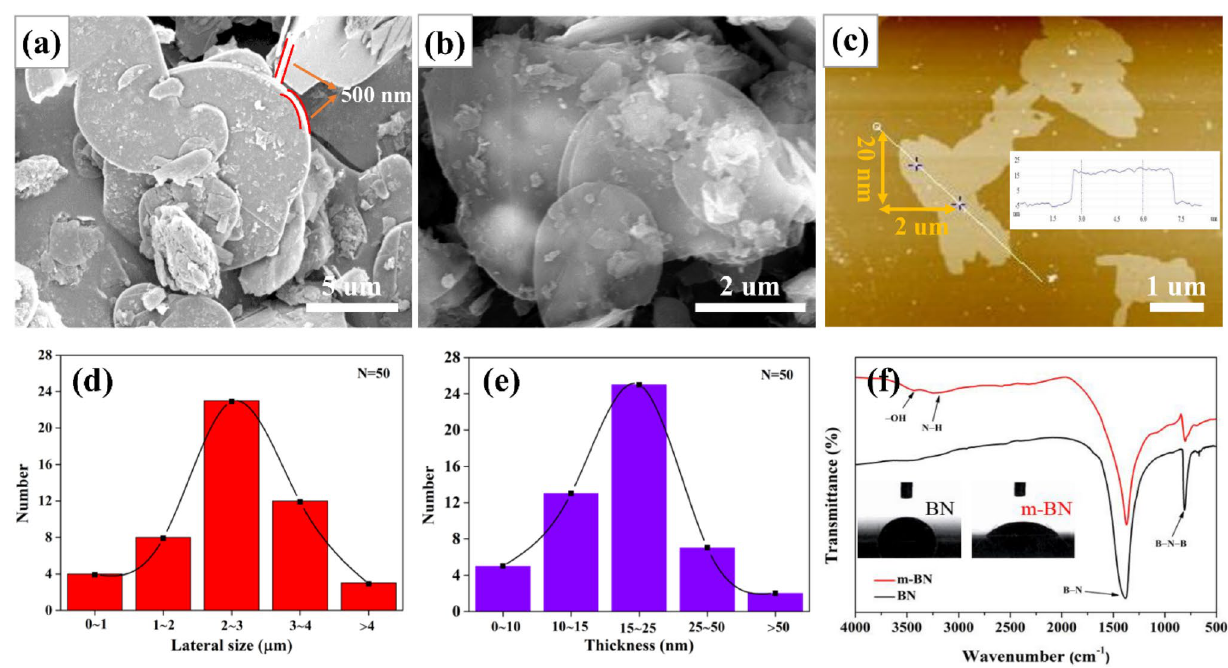
Fig. 1 Characterizations of original BN and m‑BN. a, b are SEM images of pristine BN and m‑BN. c AFM image, d diameter length and e thickness distribution of m‑BN. f FT‑IR analysis of BN and m‑BN. Insets are the corresponding contact angle test